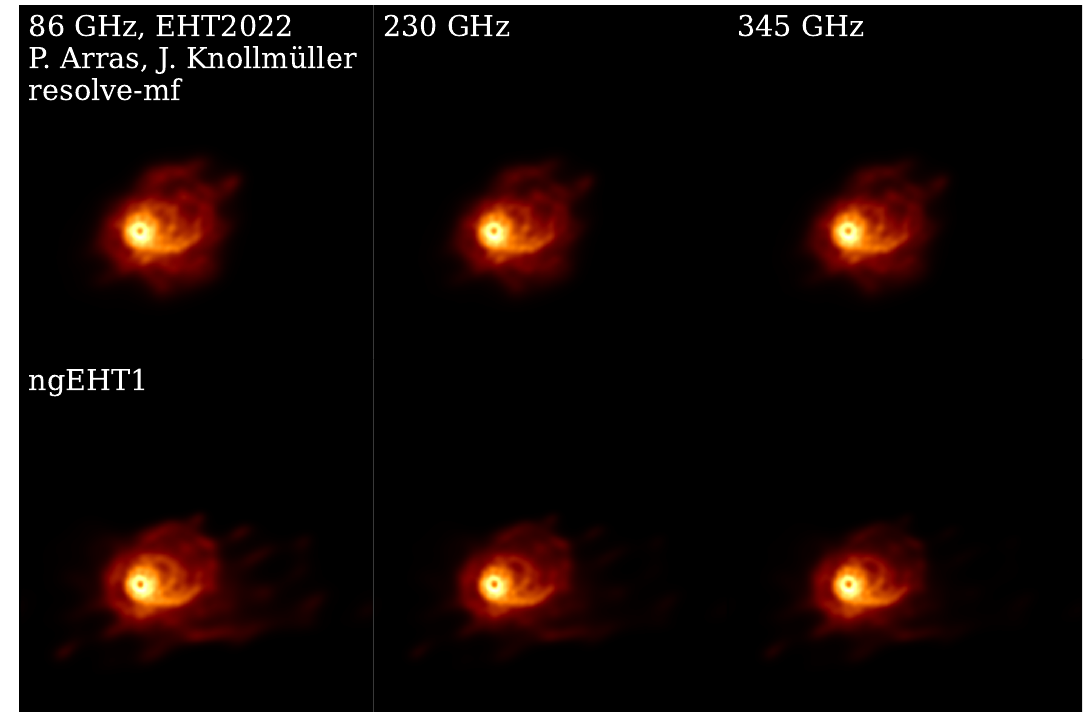
Figure 11. Multi-frequency resolve reconstructions of the Challenge 2 M87 model at 86, 230, and 345 GHz (first frame) with the EHT2022 and ngEHT1